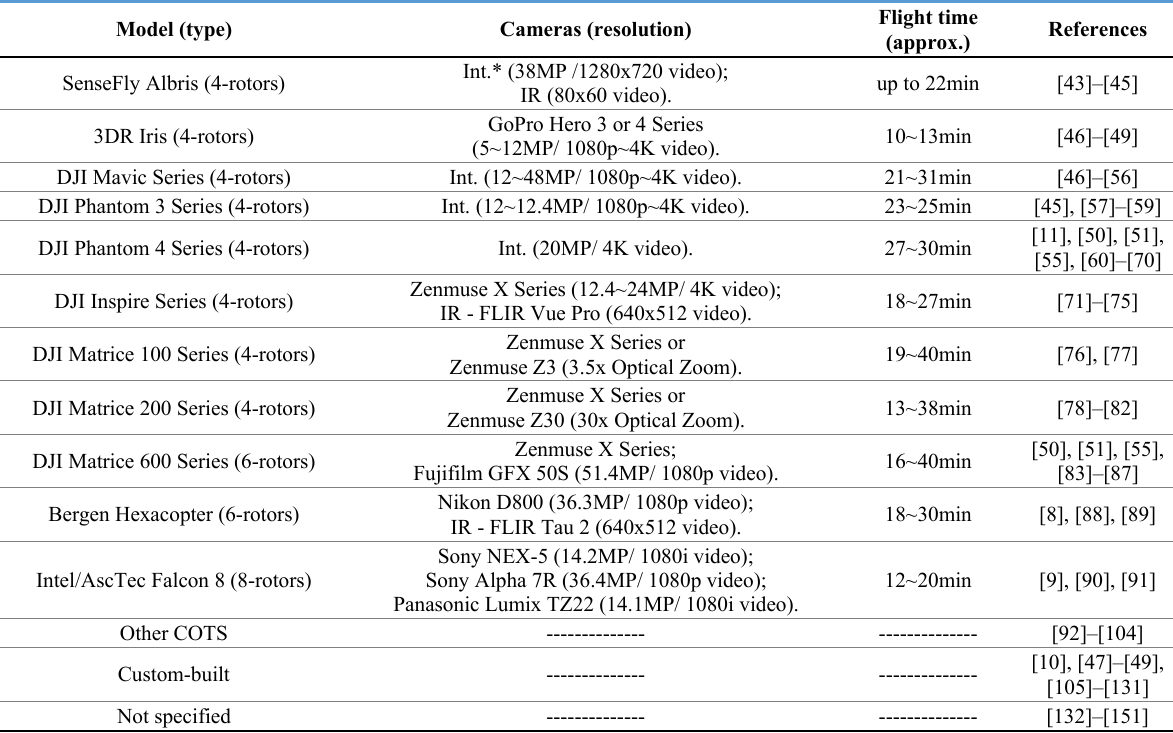
Table 2. UAVs used for bridge inspection found in the